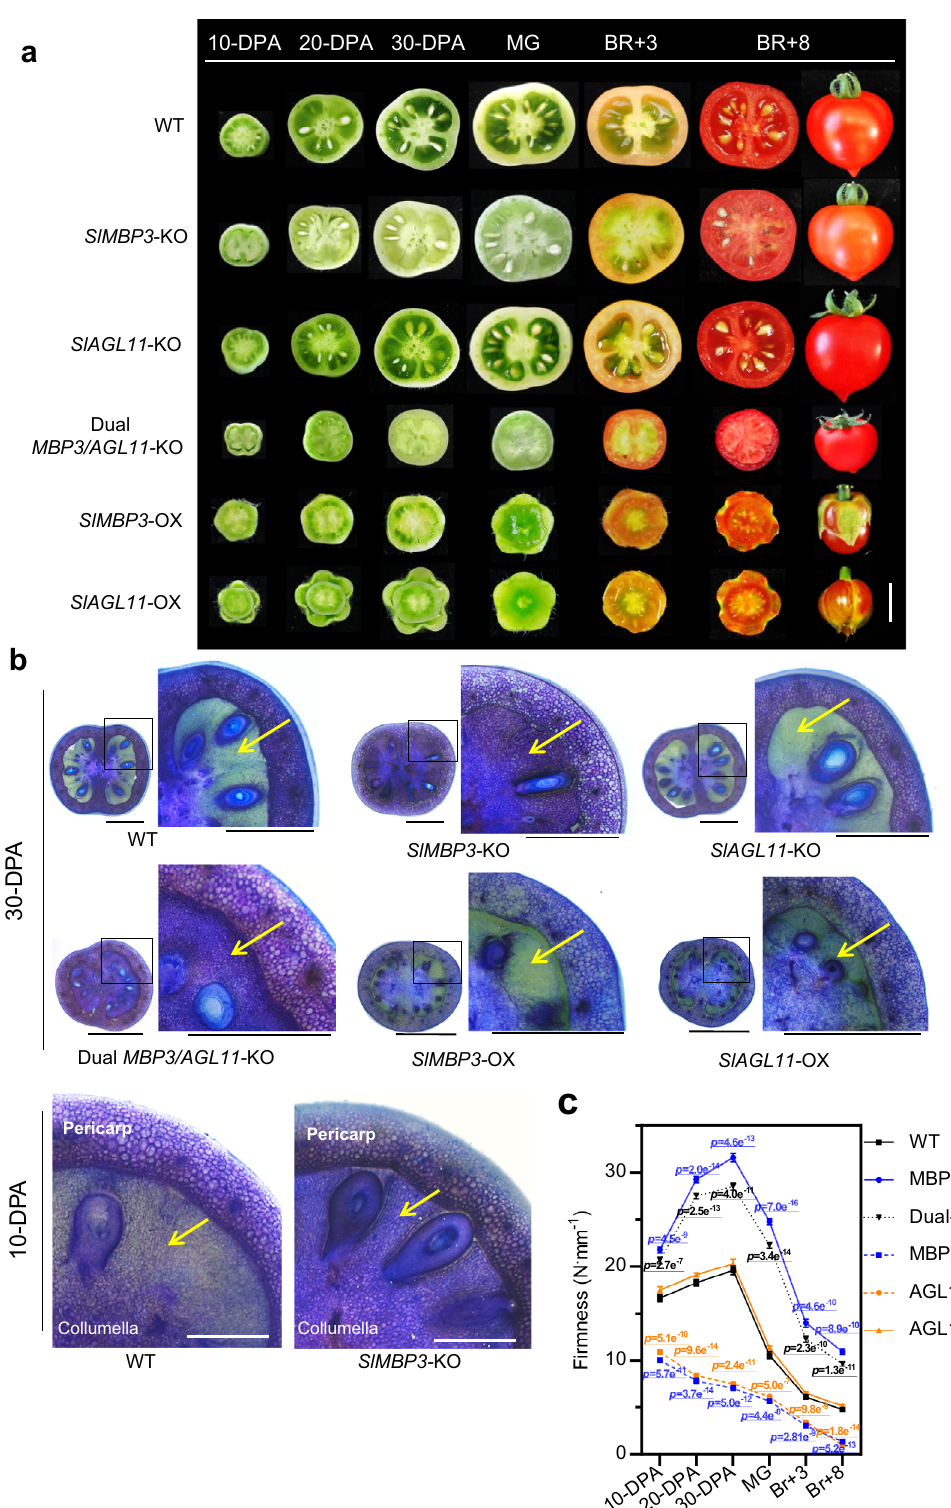
(Fig. 4b). By contrast, SlMBP3 displayed consistent expression in the placenta of auxin-induced parthenocarpic fruit (Fig. 4b). These dis- tinctive expression patterns are indicative of speci fi c roles for SlAGL11 and SlMBP3 in seed development and placental tissue dif- ferentiation, respectively. Global transcriptomic pro fi ling performed by RNA-seq coupled to genome-wide ChIP-seq provided insight into genes